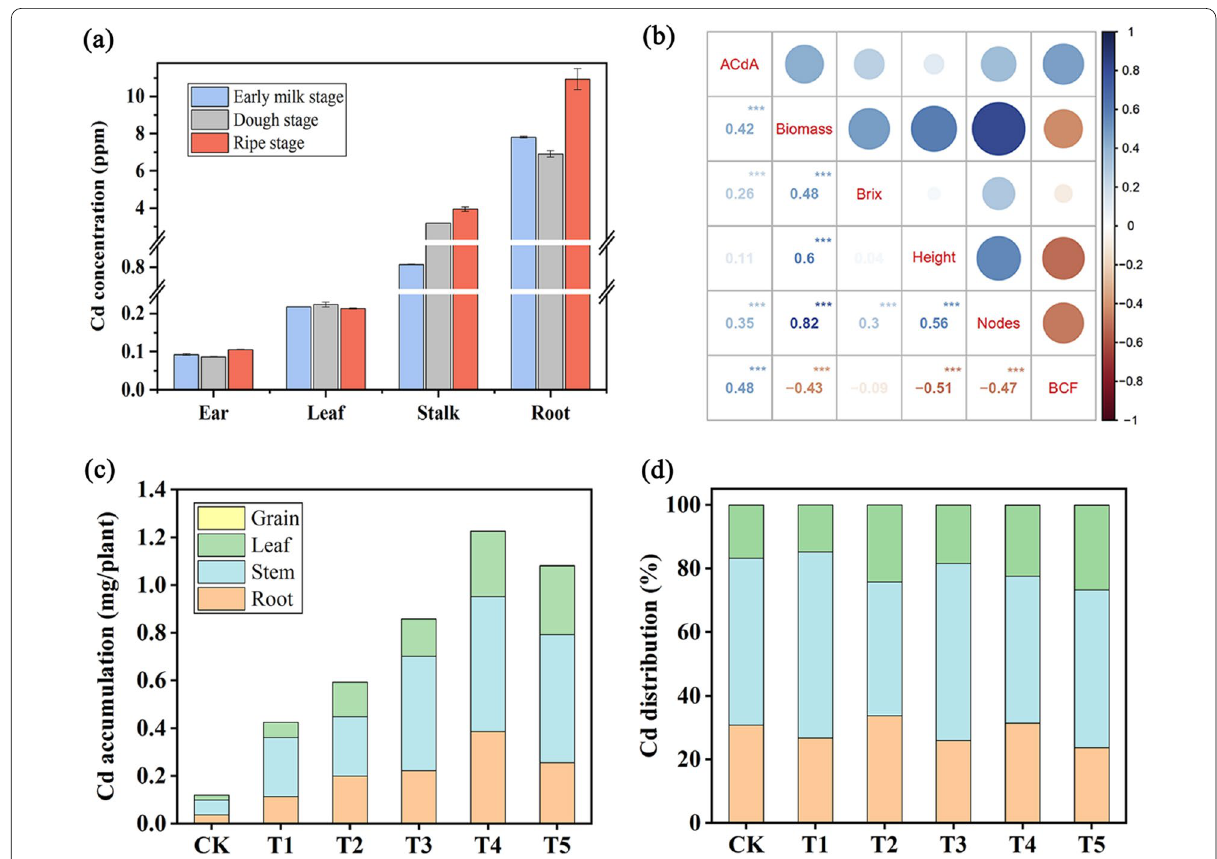
Fig. 4 Characteristics of sweet sorghum in Cd phytoremediation. a The Cd concentrations in different sorghum dried tissues. Adapted from [22], Elsevier B. V., Copyright (2021). b Pearson pairwise correlations among sorghum aboveground Cd accumulation (ACdA), the bioaccumulation factor (BCF), and bioenergy‑related traits. Reprinted from [21], Elsevier B. V., Copyright (2020). The Cd accumulation ( c ) and distribution |( d ) in the different organs of sweet sorghum (grown in soils with Cd concentrations of 0.25 (CK), 2.3 (T1), 5.9 (T2), 7.2 (T3), 18.1 (T4), and 33.6 (T5) for 167 days). Adapted from [71], with permission of the